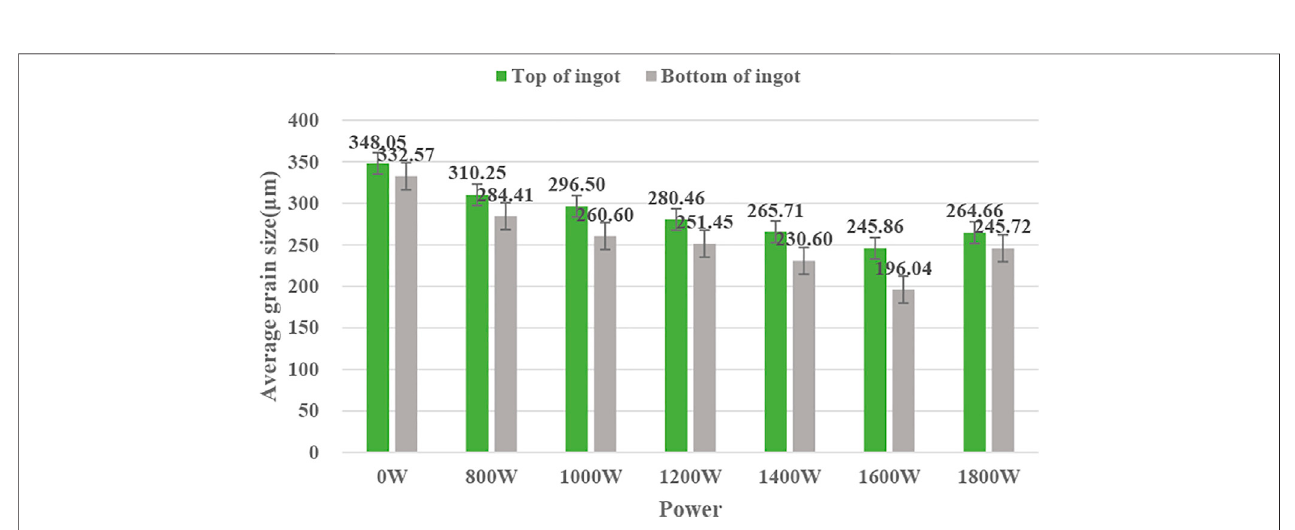
FIGURE 4 | Average grain measure of α -Al grains at agent positions of ingots treated with diverse ultrasonic powers.